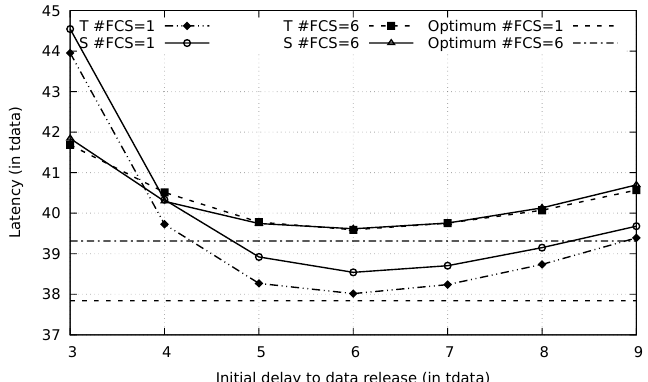
Figure 7. Latency as a function of initial delay to data release, for destination distant 30 hops from sender. Theoretical (T) and simulated (S) results for FCS cardinalities of 1 and 6. The two straight lines represent theoretical results for optimal (variable) initial